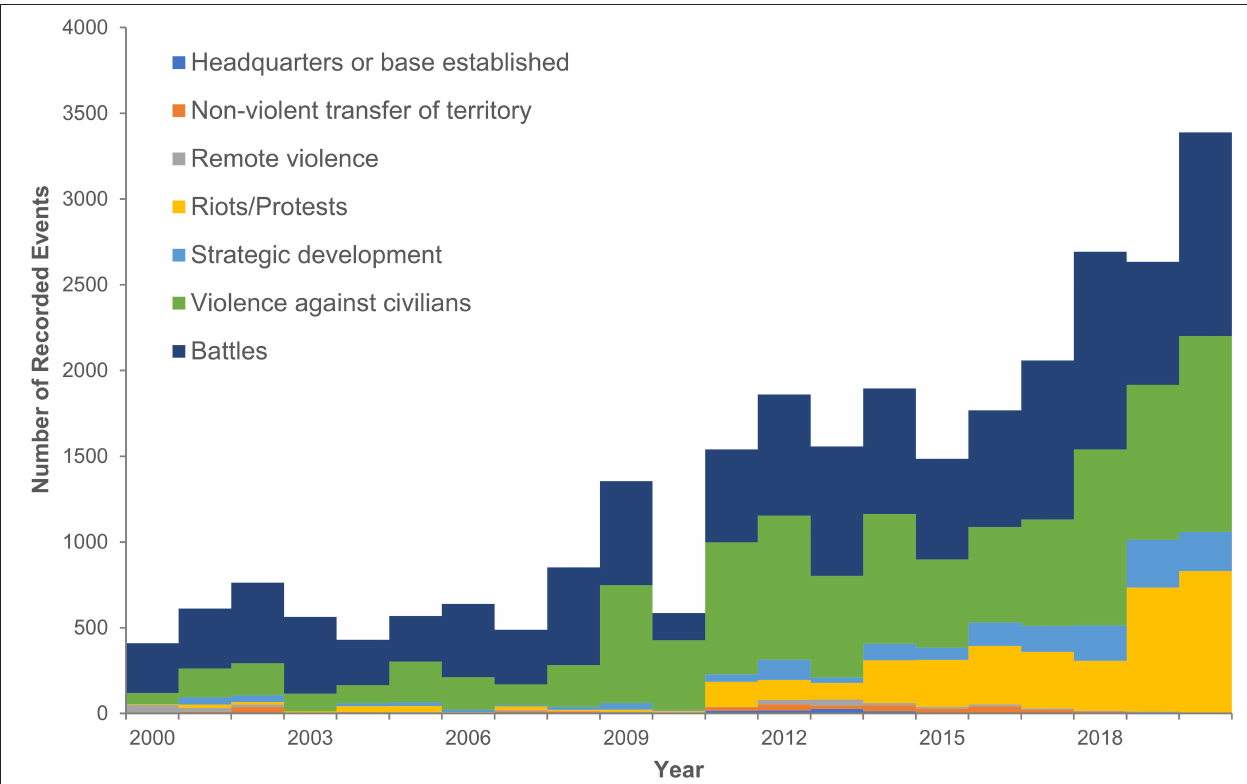
FIGURE 3 | Recorded conflict events in DRC, broken down by event type (Source: Clionadh et al.,